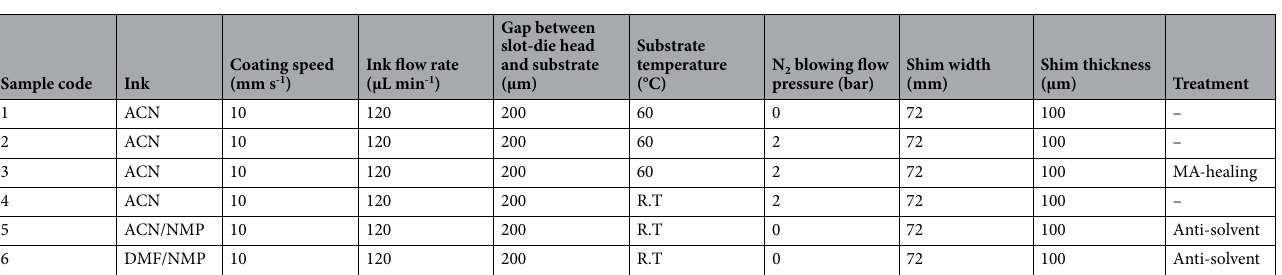
Table 1. Parameters used for slot-die coating of perovskite